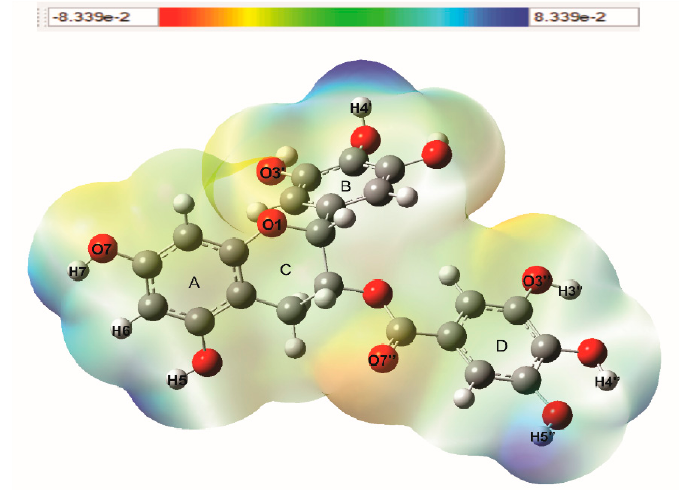
Figure 3. Molecular electrostatic potential (MEP) map of epigallocatechin gallate ( EGCG), calculated with B3LYP/6-31G (d,p) methodology.